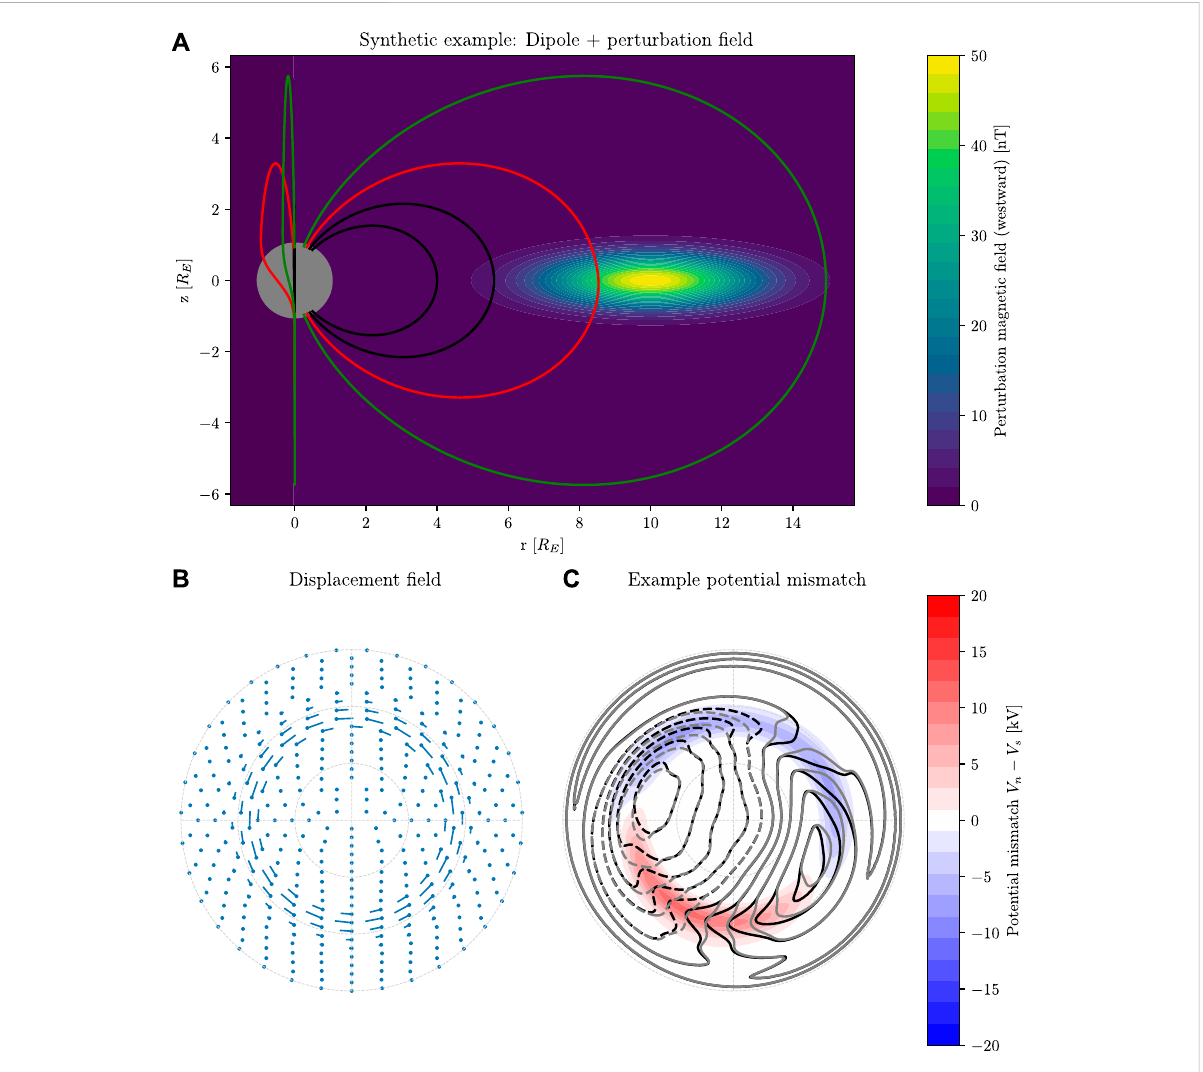
FIGURE 1 Conceptual illustration of the displacement fi eld and its effect on ionospheric convection: (A) Magnetic fi eld lines of a dipole magnetic fi eld perturbed by a westward magnetic fi eld indicated in color (a 2D Gaussian with peak value of 50 nT). The magnetic fi eld lines are traced from − 60 ° , − 65 ° (black), − 70 ° (red), and − 75 ° (green) to the northern hemisphere. The dipole has a reference magnetic fi eld (Fraser-Smith, 1987; Laundal and Richmond, 2017) of 28,000 nT. (B) The corresponding displacement fi eld. The dots show footpoints in the southern hemisphere and the pins pointtotheirconjugatepointinthenorthernhemisphere,inacoordinatesystemwheredipolemagnetic fi eldlinesmaptothesamelocations.Inthis, and in all subsequent polar plots, the view is down at the magnetic pole in the northern hemisphere, and through the Earth for the southern hemisphere, with noon on top and midnight at the bottom. The plots cover 60-90 ° latitude, with dashed circles every 10 ° . (C) An ionospheric convection electric potential in the southern hemisphere (grey) and the corresponding potential in the northern hemisphere (black) under the assumption that the potential maps along magnetic fi eld lines between hemispheres. The color in the background show apparent potential mis fi t at coordinates that are connected by dipole magnetic fi eld lines. The color scale used here is also used in subsequent fi